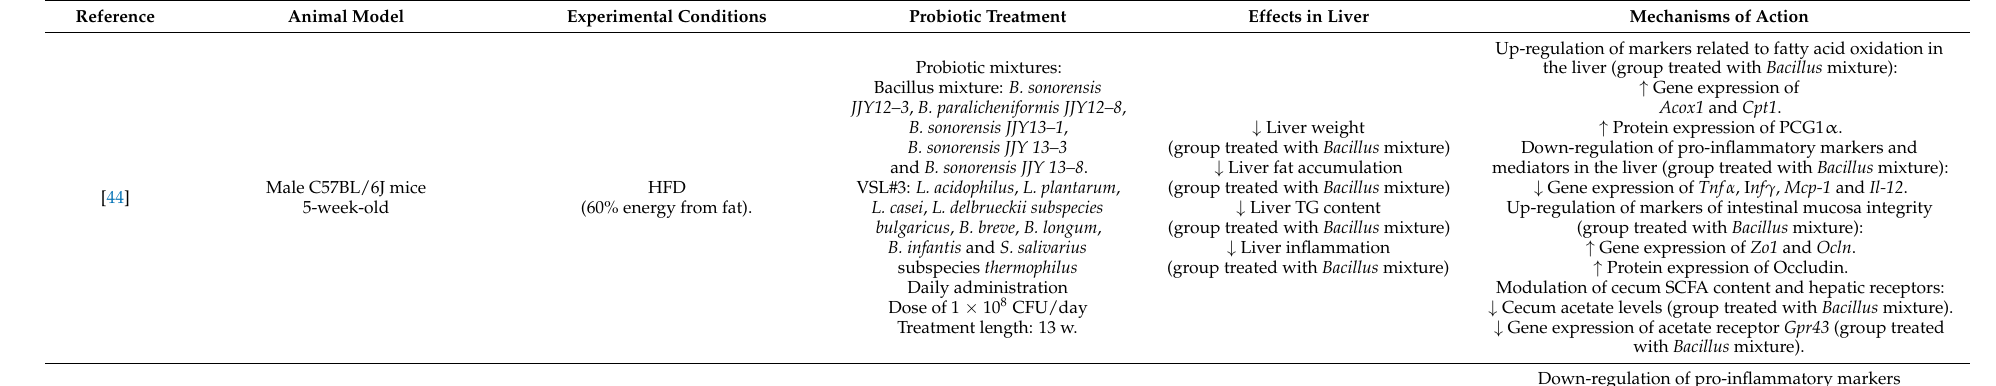
Table 2. Preclinical studies (rodent models) addressing the effects of different probiotic mixtures in diet-induced